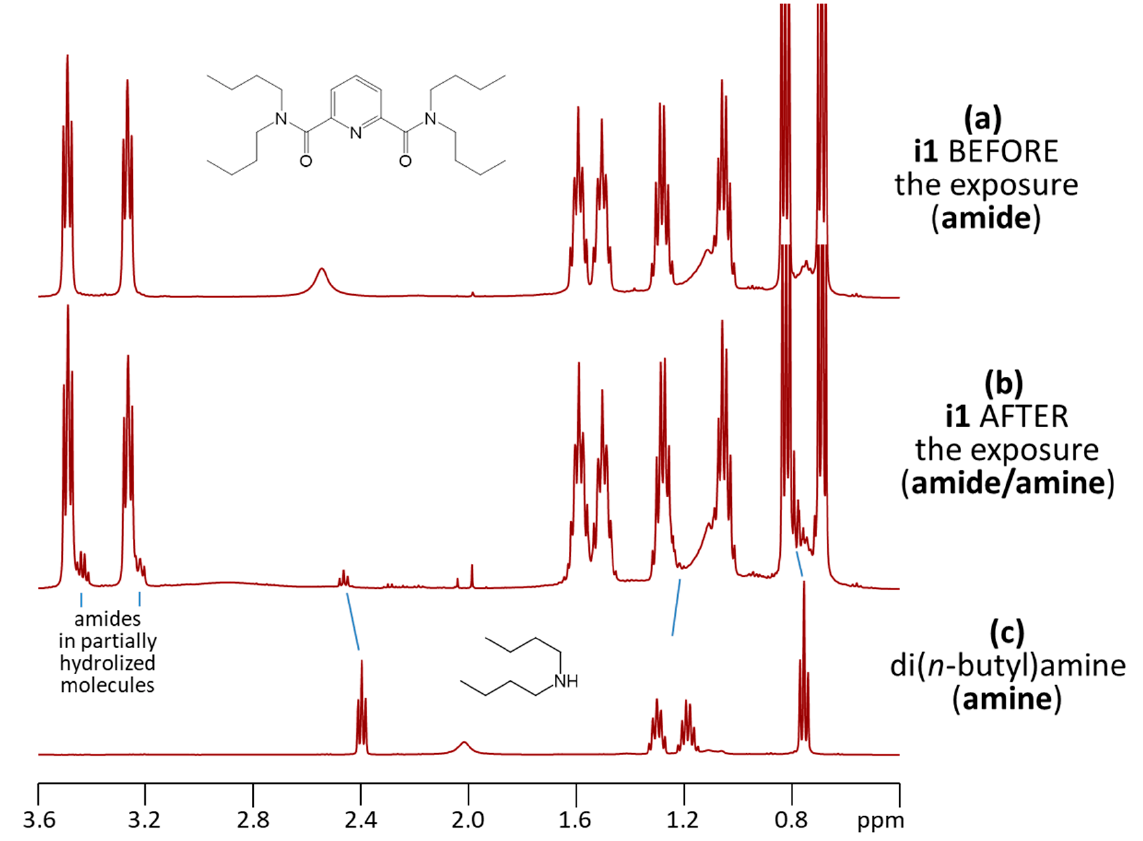
Figure 6. The aliphatic parts of room temperature 1 H NMR spectra containing the signals of alkyl protons of amide/amine substituents for nitrobenzene solutions of ( a ) i1 before the exposure, ( b ) i1 after the exposure, ( c ) di( n -butyl)amine.